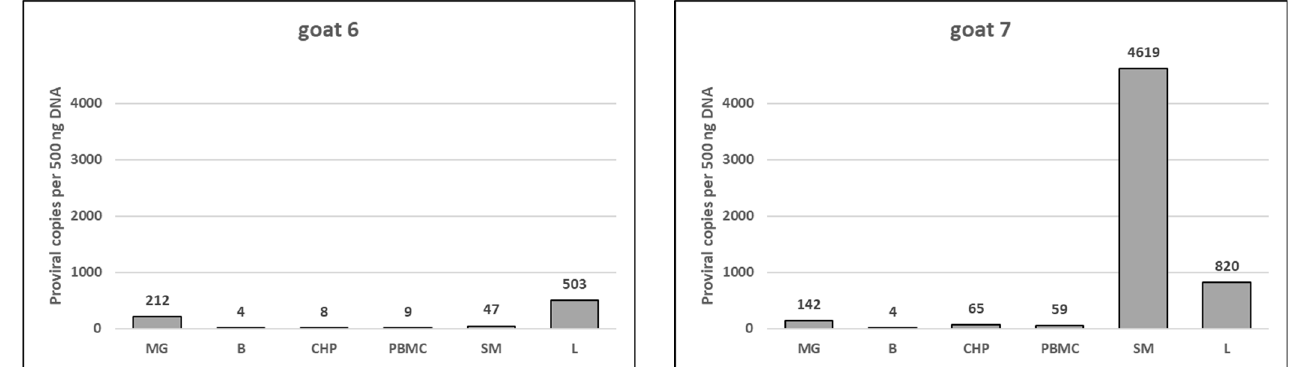
Figure 8. Quantification of SRLV proviral load in different organs and cells of goats analyzed in this study. PBMC—Peripheral blood mononuclear cells, L—Lung, SM—Synovial membrane, B—Brain, CHP—Choroid plexus, MG—Mammary gland. Mean value of SRLV proviral copy number is